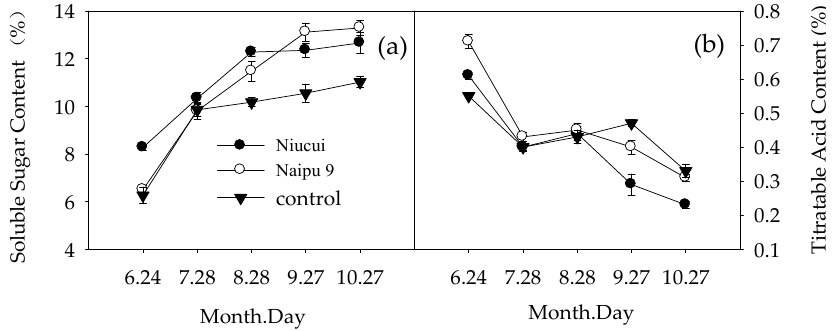
Figure 1. Effects of spraying calcium fertilizer on soluble sugar content ( a ) and titratable acid content ( b ) of apple fruit.